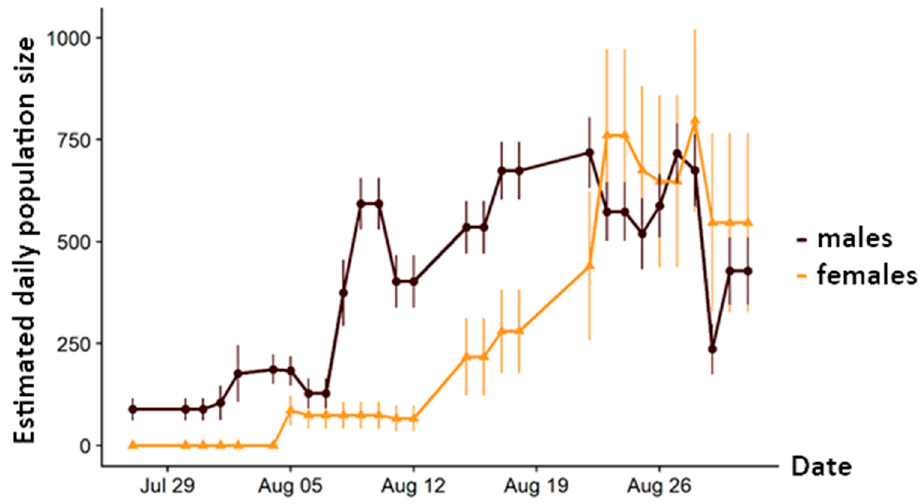
Figure 1. Estimated daily population size of both sexes of Erebia pronoe based on the best Popan model in MARK: Phi(g + t) p(g + hours) pent(g × t) N(g × t).